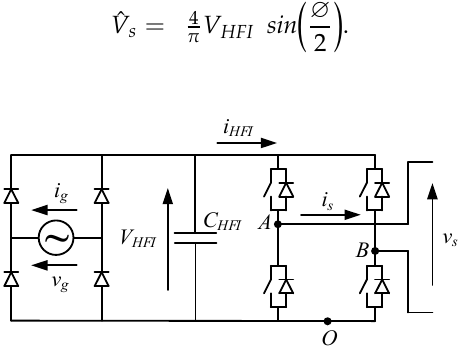
Figure 6. Track side conversion stage schematic.